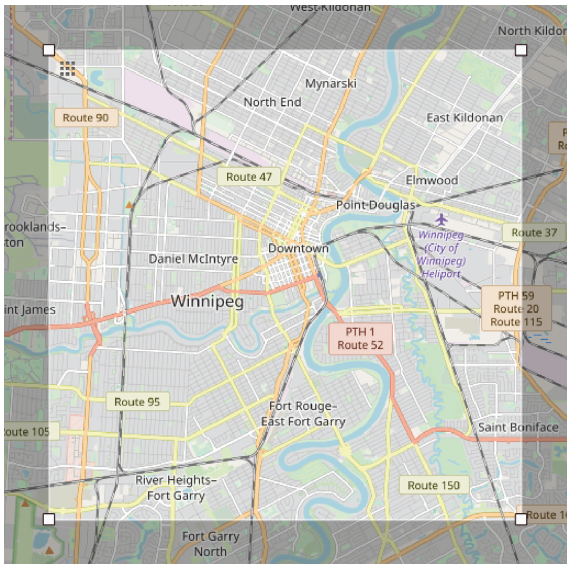
Figure 2: Center of Winnipeg that has been used for simulation experiments (the size of the simulated area amounts to 104 square kilometers or 40 square miles).